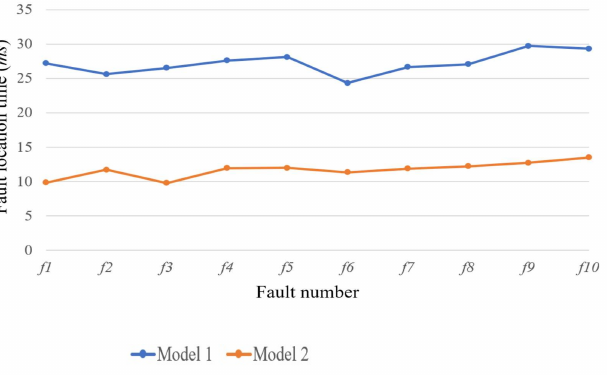
Figure 11. Comparison of fault location time